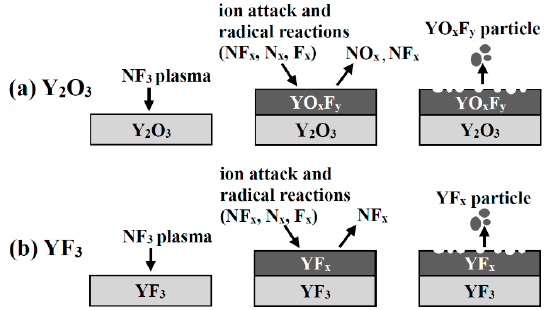
Figure 5. Schematic diagram of yttrium oxyfluoride film deposition and etching behavior of ( a ) Y 2 O 3 and ( b ) YF 3 coatings. Table 1. X-ray photoelectron spectroscopy (XPS) analysis results of Y 2 O 3 and YF 3 coatings before and after exposure to NF 3 plasma: ( a ) Y 2 O 3 and ( e ) YF 3 before etching; ( b ) Y 2 O 3 and ( f ) YF 3 after etching of the powered electrode; ( c ) Y 2 O 3 and ( g ) YF 3 after etching of the grounded electrode; ( d ) Y 2 O 3 and ( h ) YF 3 after etching of the grounded wall.